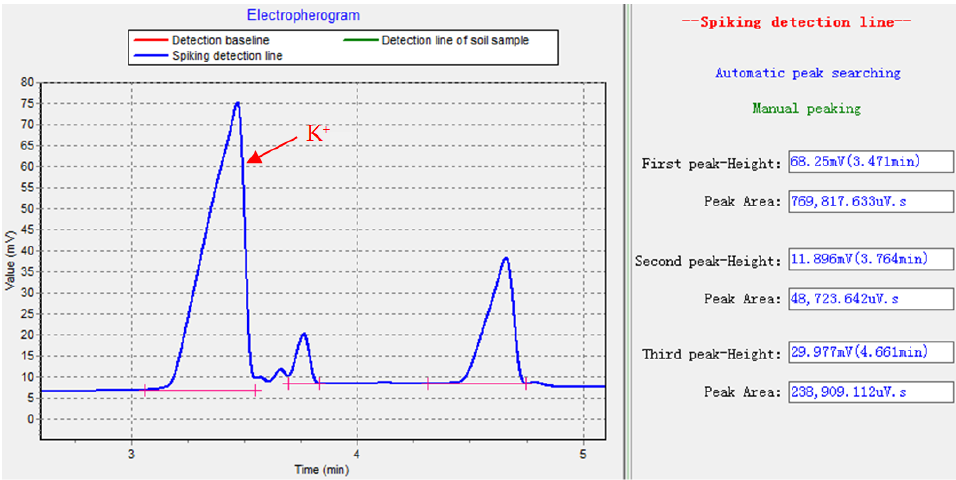
Figure 5. Peak height and peak area of the electropherogram for soil sample B 1 after adding standard reagent.